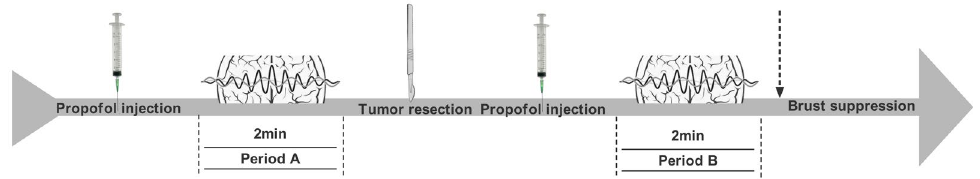
Figure 2. ECoG recording and assessing; Period A (about 2 min) after the propofol bolus (0.01 mg/kg) but before lesion resection; Period B (about 2 min) after lesion resection and the propofol bolus (0.01